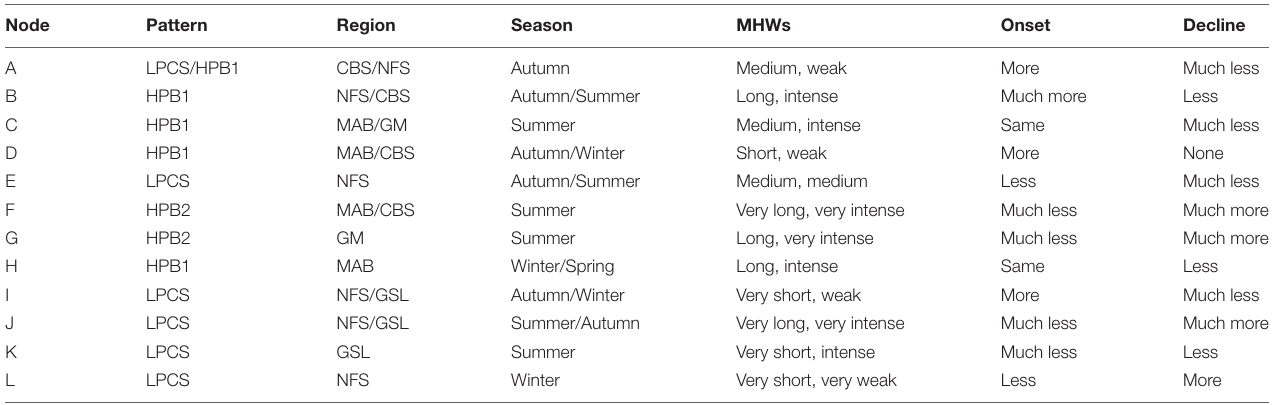
TABLE 5 | A typology of marine heatwaves (MHWs) as categorized by the